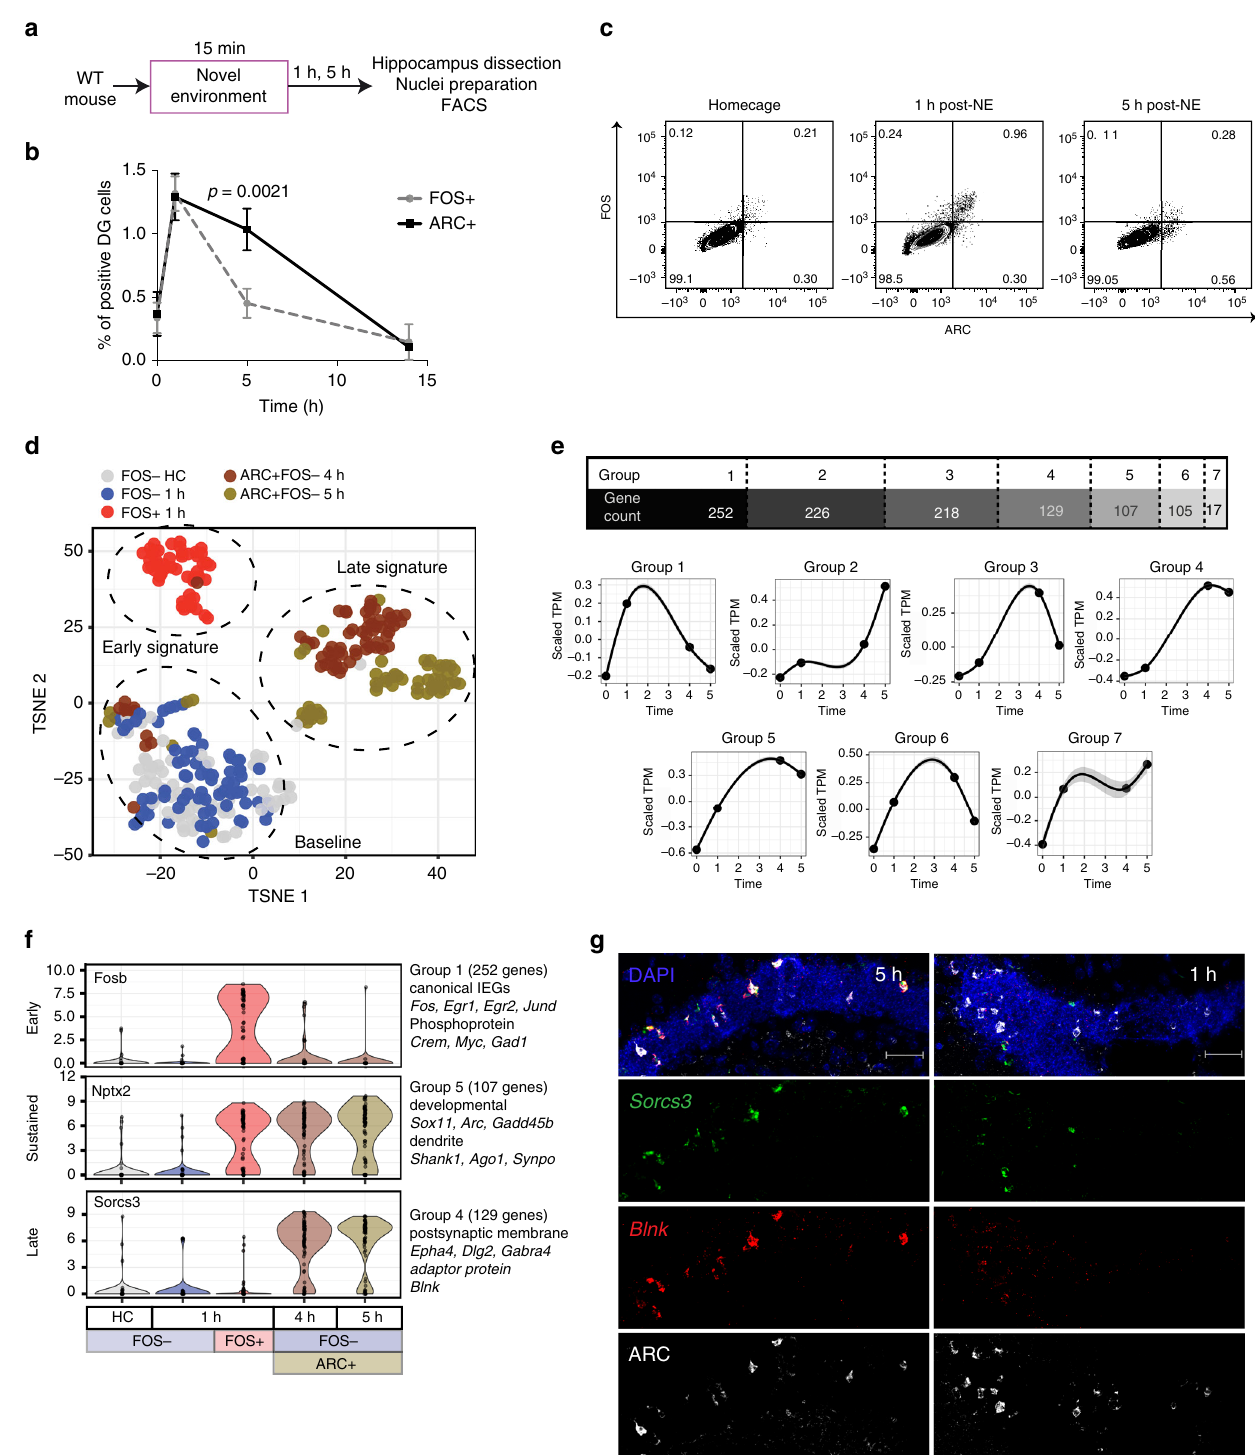
Fig. 4 A dynamic transcriptional response occurs in DG neurons following NE exposure. a Experimental paradigm used for fl ow cytometry isolation of DG neurons at late time points post NE exposure. b Percentage of FOS + (gray) and ARC + (black) DG neurons in animals from HC and 1 h, 5 h or 15 h after a 15-min NE exposure ( n = 3 – 14 mice per time point, ±S.D), p values are indicated for Mann – Whitney test. At least 150,000 DG nuclei were analyzed per mouse. c Representative FACS plots showing FOS and ARC expression in DG neurons (PROX1 + CTIP2 + single nuclei) in HC and at 1 h or 5 h post-NE exposure. Percentages of nuclei per gate are indicated. d T-SNE of gene expression in DG nuclei. FOS − HC and FOS − 1 h cluster into the baseline signature. FOS + 1 h nuclei cluster into the early signature, and ARC + FOS – from both 4 and 5 h cluster into the late signature. e Count of all DEGs from the comparison between HC and either FOS + 1 h, ARC + FOS – 4 h, or ARC + FOS – 5 h nuclei. Genes are grouped into categories based on temporal expression pattern. Y -axis: mean standardized expression across all genes for the given category. f Violin plots for genes representative of the key temporal groups of early, sustained, and late. g Fluorescent in situ hybridization for two genes present in the late signature, Sorcs3 and Blnk , combined with immunohistochemical detection of ARC protein. Left side: 5 h post NE exposure. Right side: 1 h post NE exposure. Scale bar = 50 μ m NATURE COMMUNICATIONS| (2018) 9:3084 |DOI: